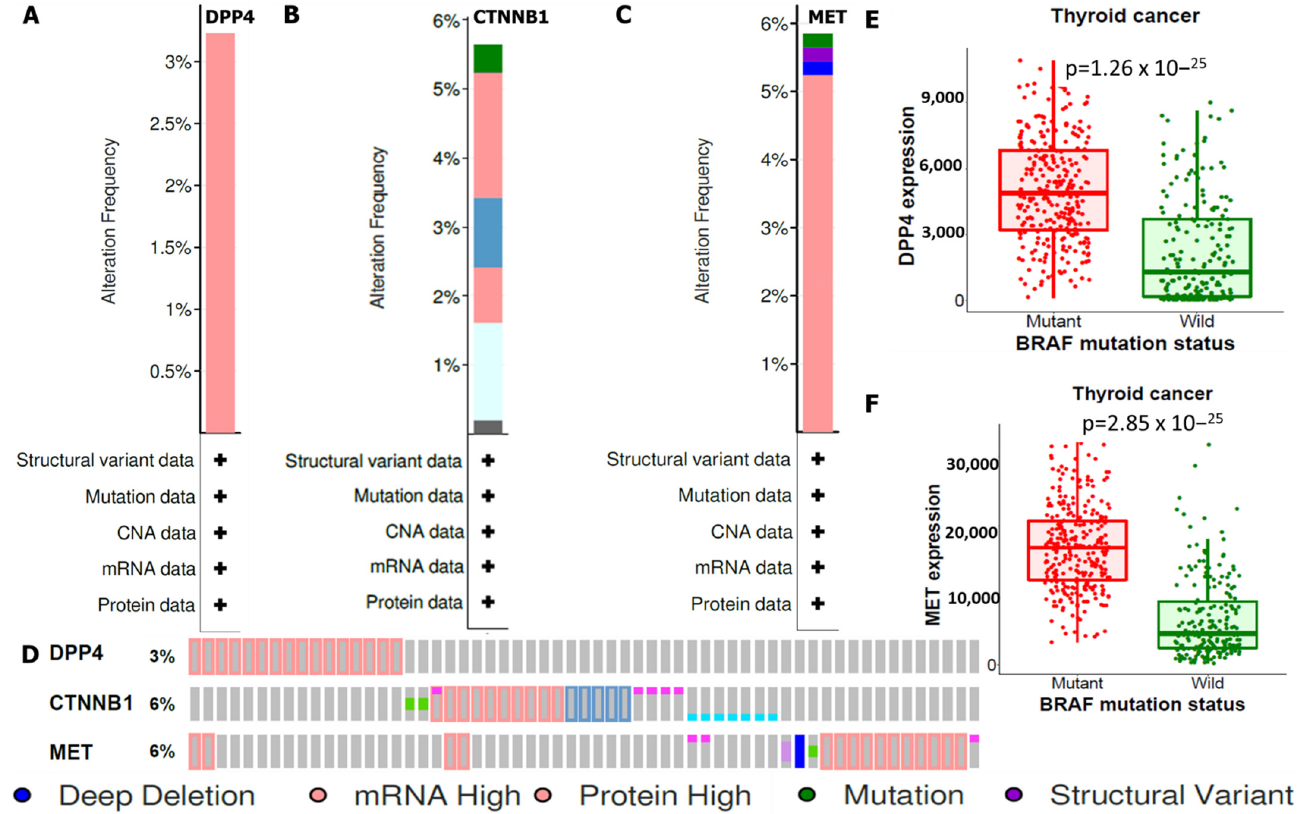
Figure 3. Genetic mutations based on percentages due to amplification of ( A ) DPP4 (3%), ( B ) CTNNB1 (6%), and ( C ) MET (6%), including deep deletions (blue), mRNAs (red), proteins (red), mutations (green), and structural variants (purple). ( D ) Individual genetic alteration profile of DPP4/CTNNB1/MET in THCA. ( E , F ) BRAF mutations promoted overexpression of DPP4 and MET compared with the wild type, with p < 0.05 considered statistically significant.